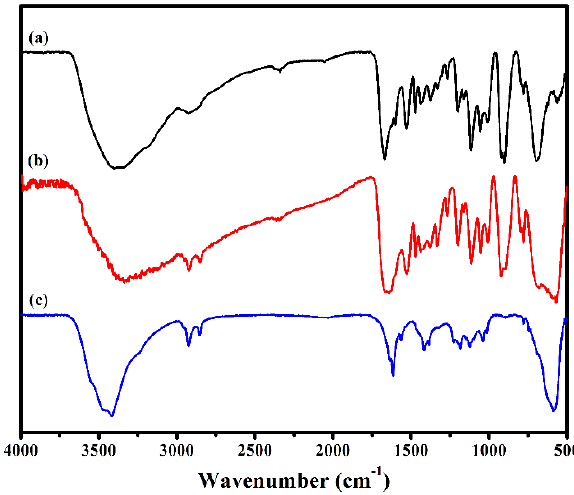
Figure 3. FTIR spectra of (a) 1 , (b) Fe 3 O 4 @1 and ( c ) Fe 3 O 4 .